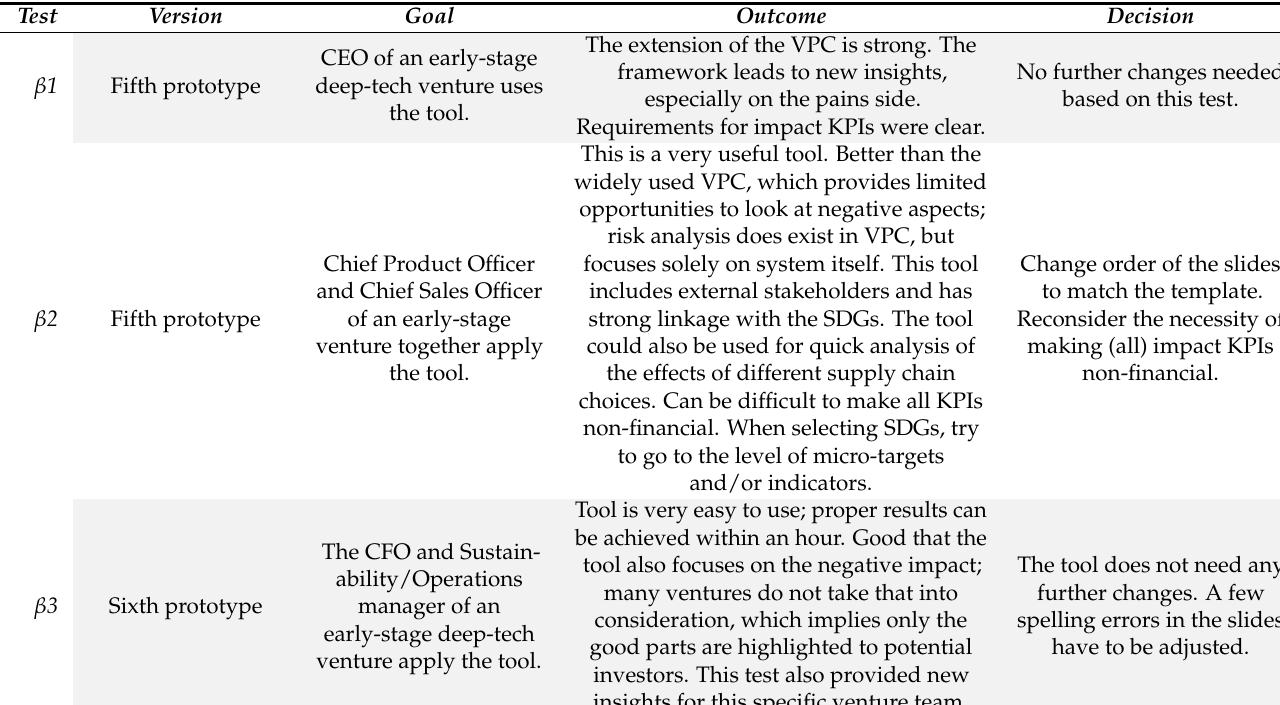
Table A3. Overview of beta-tests (conducted in November-December